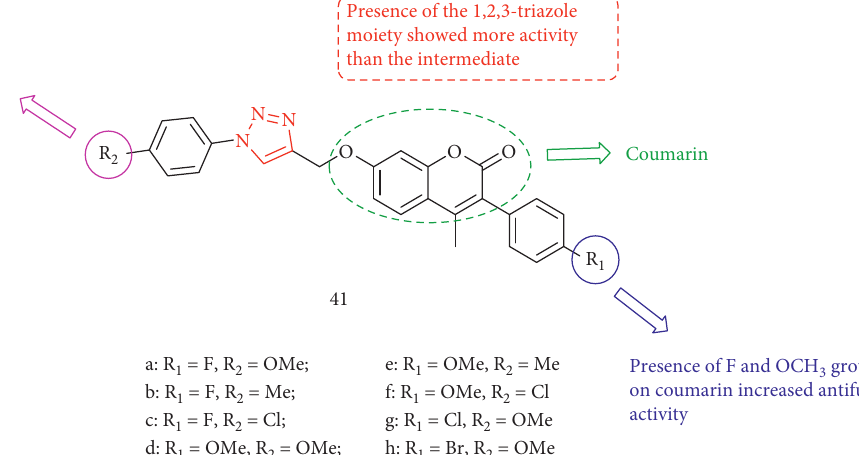
Figure 4: Chemical structure coumarin-based 1,2,3-triazole compounds.